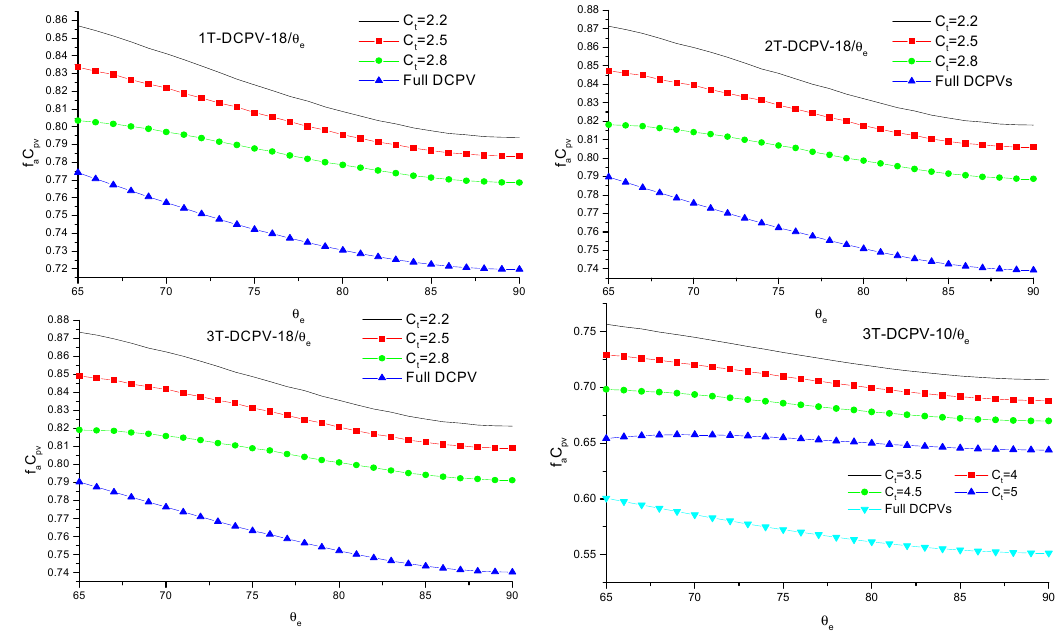
Figure 26. Effects of θ e on f a C pv , the photovoltaic performance coefficient of